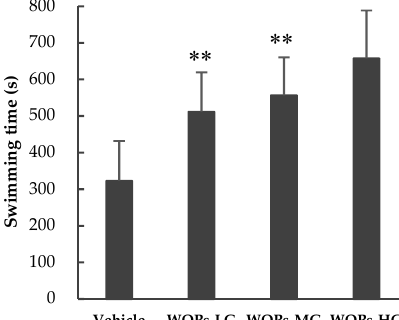
Values are expressed as mean ± SD for n = 10 mice in each group. Walnut oligopeptides low-dose group (WOPs-LG), walnut oligopeptides medium-dose group (WOPs-MG) and walnut oligopeptides high-dose group (WOPs-HG) at 110, 220 and 440 mg/kg, respectively.